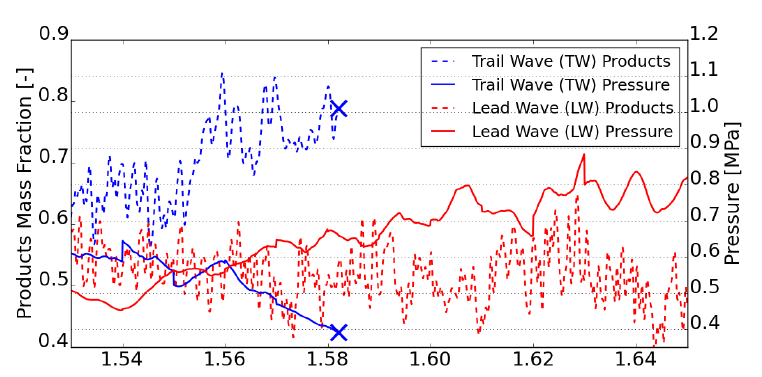
Figure 17. Trailing versus leading wave upstream flow-field total products mass fraction and detonation region pressures. Products mass fraction are dashed curves correspond to the left axis, and pressure solid curves correspond to the right